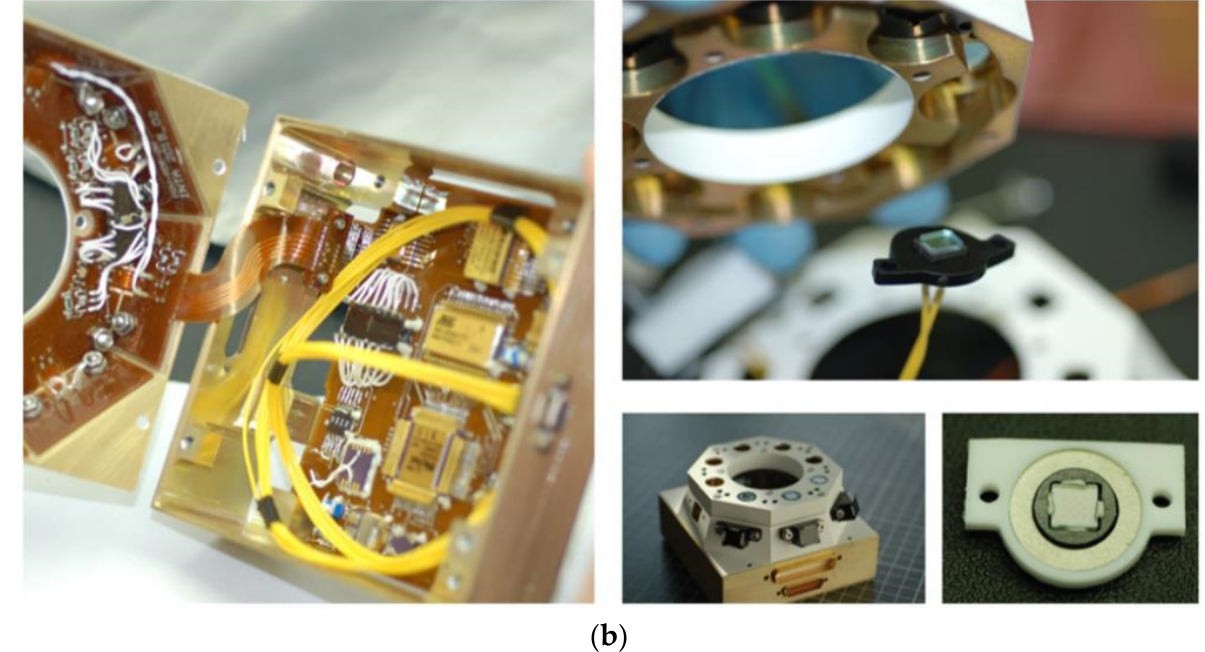
Figure 8. ( a ) PQV cycles description (3 × 1.5 MY); ( b ) RDS PQV assemblies under test.